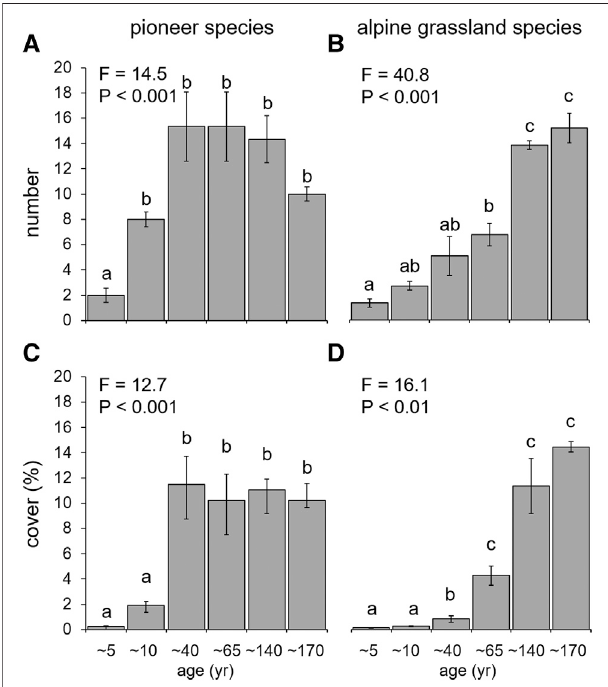
FIGURE 3 | Species number and cover for the two functional species pools along the six stages of the chronosequence: pioneer species (A,C) and alpine grassland species (B,D) . Different letters indicate signi fi cant differences ( p < 0.05) among stages according to Tukey ’ s HSD